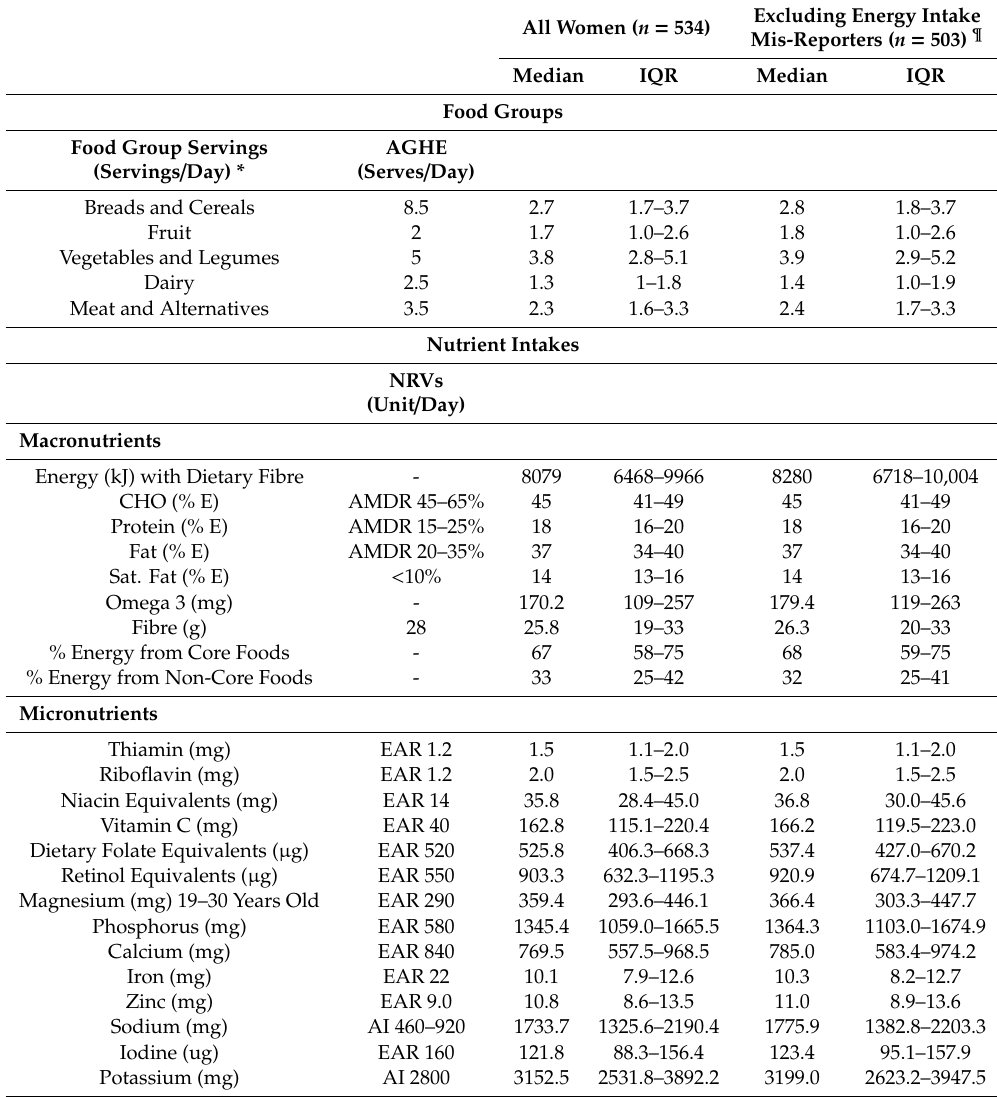
Table 2. Daily food consumption in pregnant women from the John Hunter Hospital antenatal